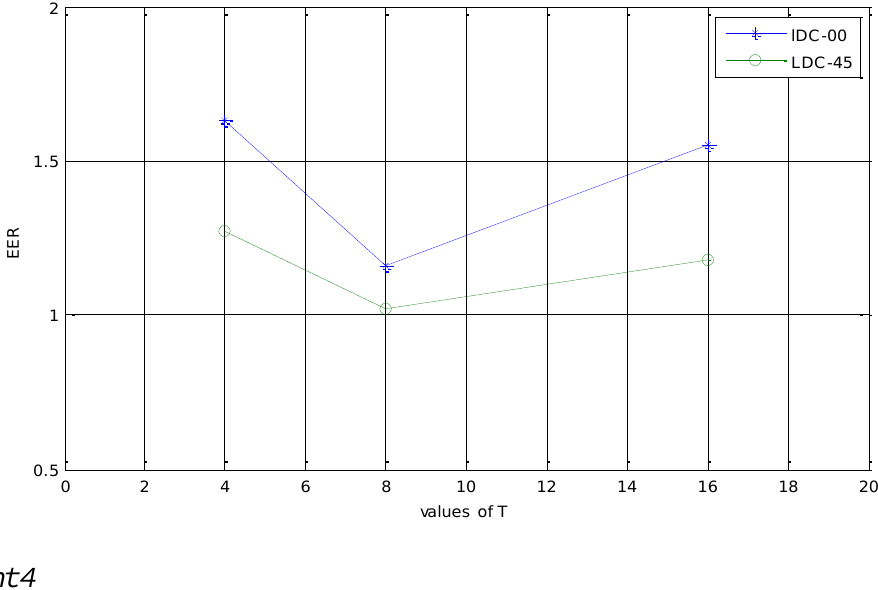
Figure 11. The effects of using different vaules of parameter T